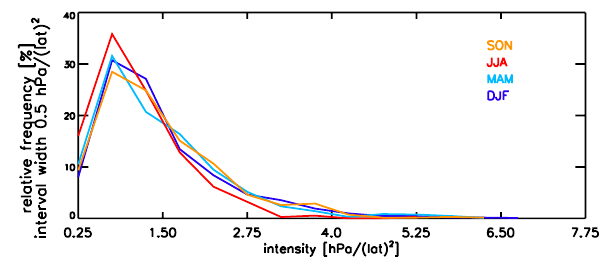
Fig. 8. Relative frequency of cyclone intensity per 0 . 5hPa ( deg . lat .) − 2 for each season.